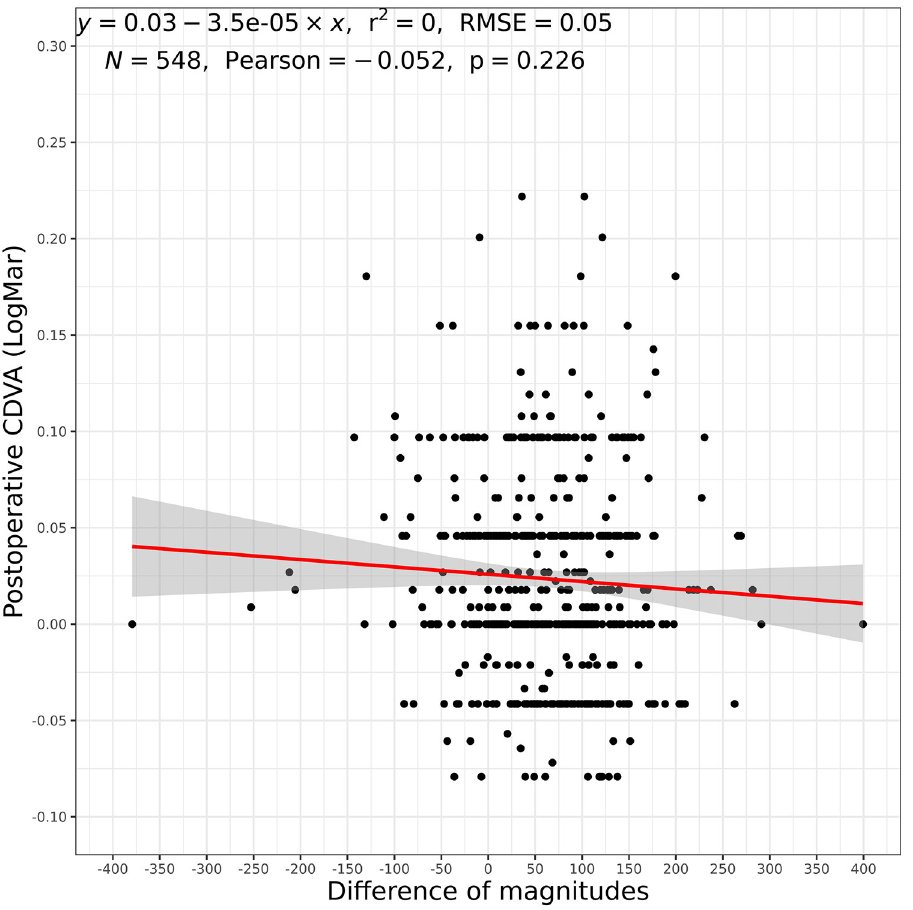
Fig 6. Difference in angle κ magnitudes in relation to CDVA (overall group). CDVA: corrected distance visual acuity, r 2 : coefficient of determination, RMSE: root mean squared error, N: number of eyes, Pearson: Pearson Correlation